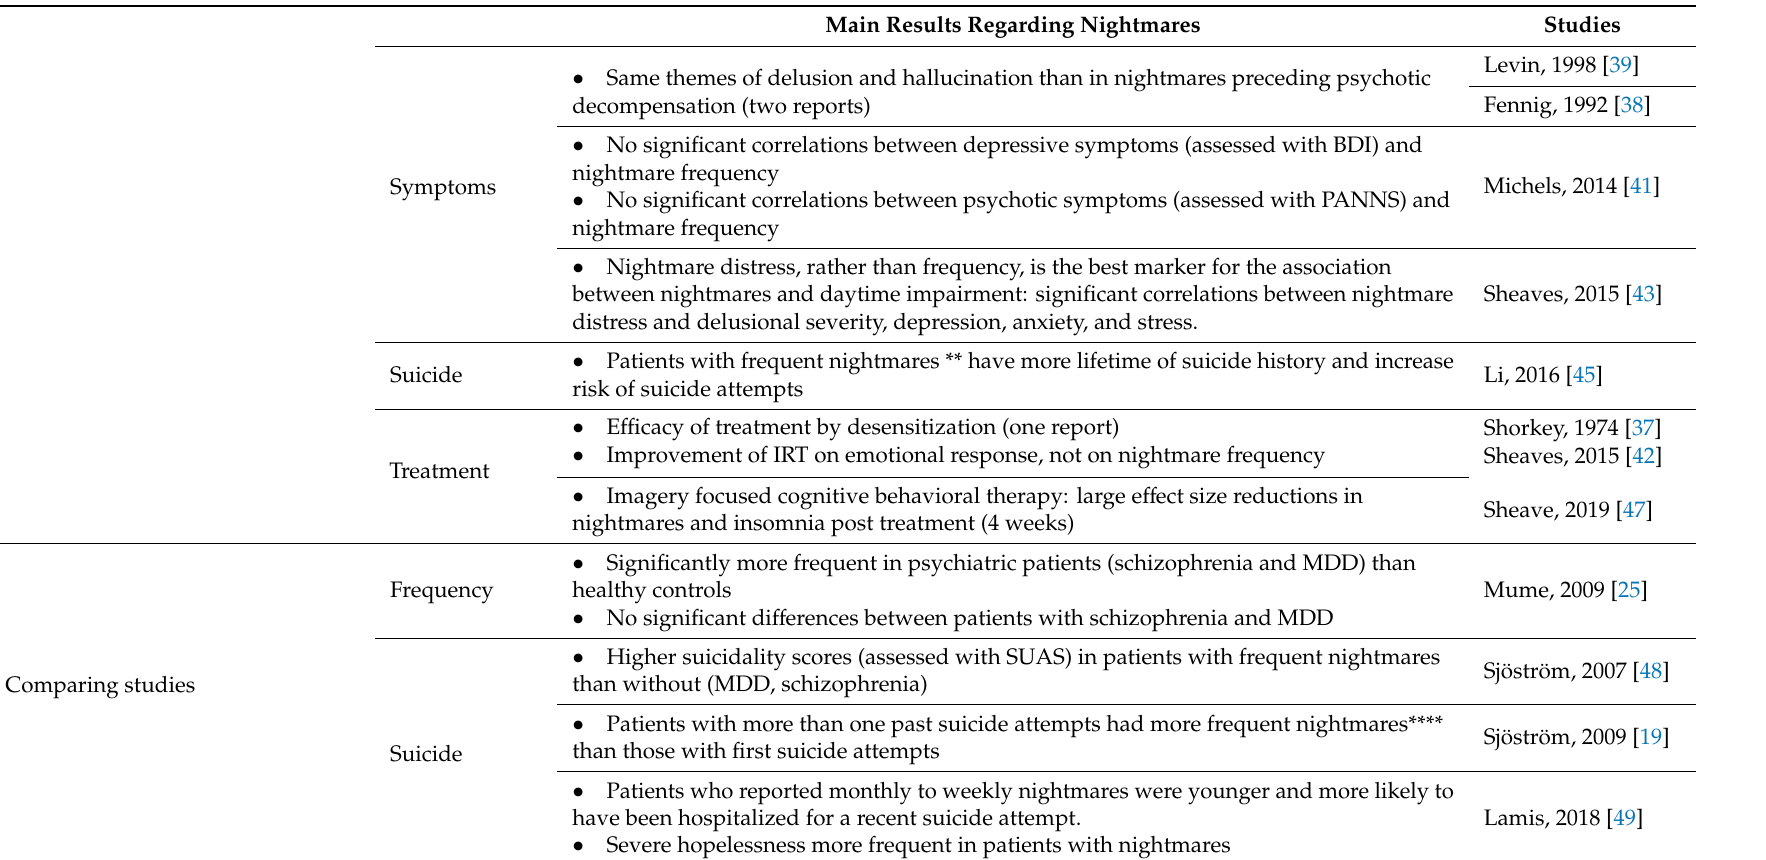
Main Results Regarding